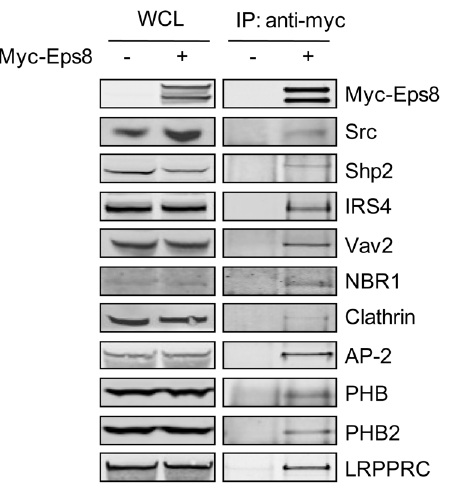
Figure 5. Full-length Eps8 interacts with a range of proteins identified in the peptide pull down assays. HEK 293T cells were either transfected with Myc-Eps8 or left untransfected. Cells were stimulated with 20 ng/ml FGF2 for 15 min and immunoprecipitated using an anti-Myc antibody. Western blot analysis was carried out on whole cell lysate and immunoprecipitation samples using antibodies against the indicated proteins.